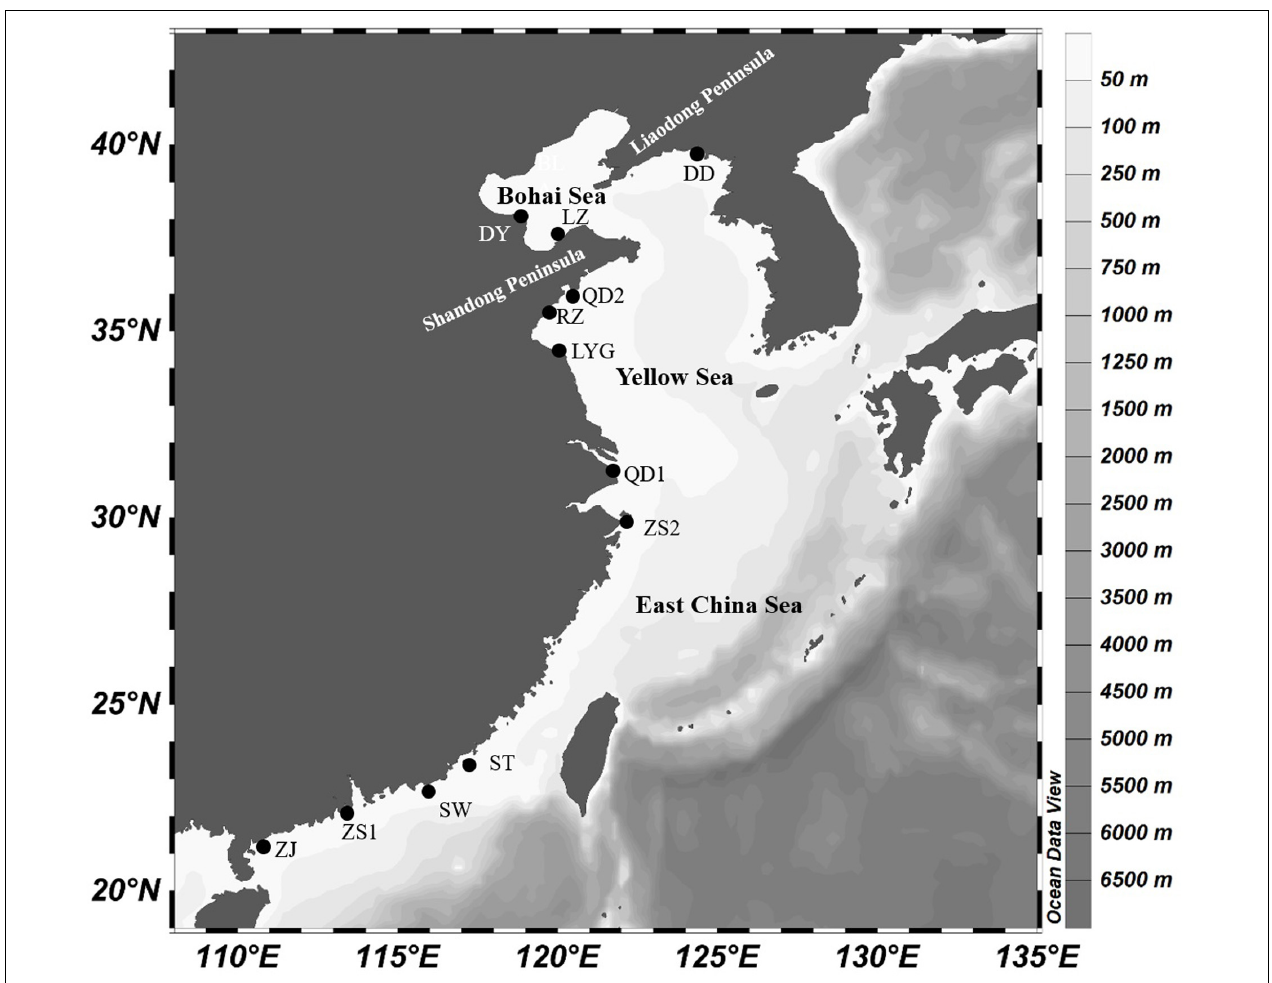
FIGURE 1 | Map showing the sampling locations along the coast of